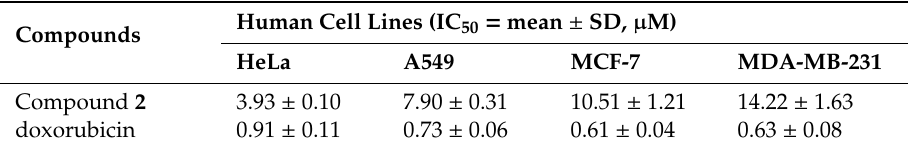
Table 3. Cytotoxicity of Compound 2 against four human tumor cell lines.